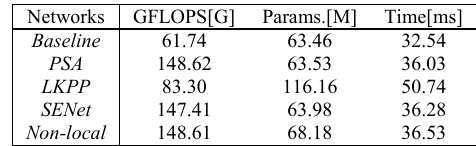
Table 6. The cost of computation and parameters compared to the state-of-art methods. The baseline is ResNet152